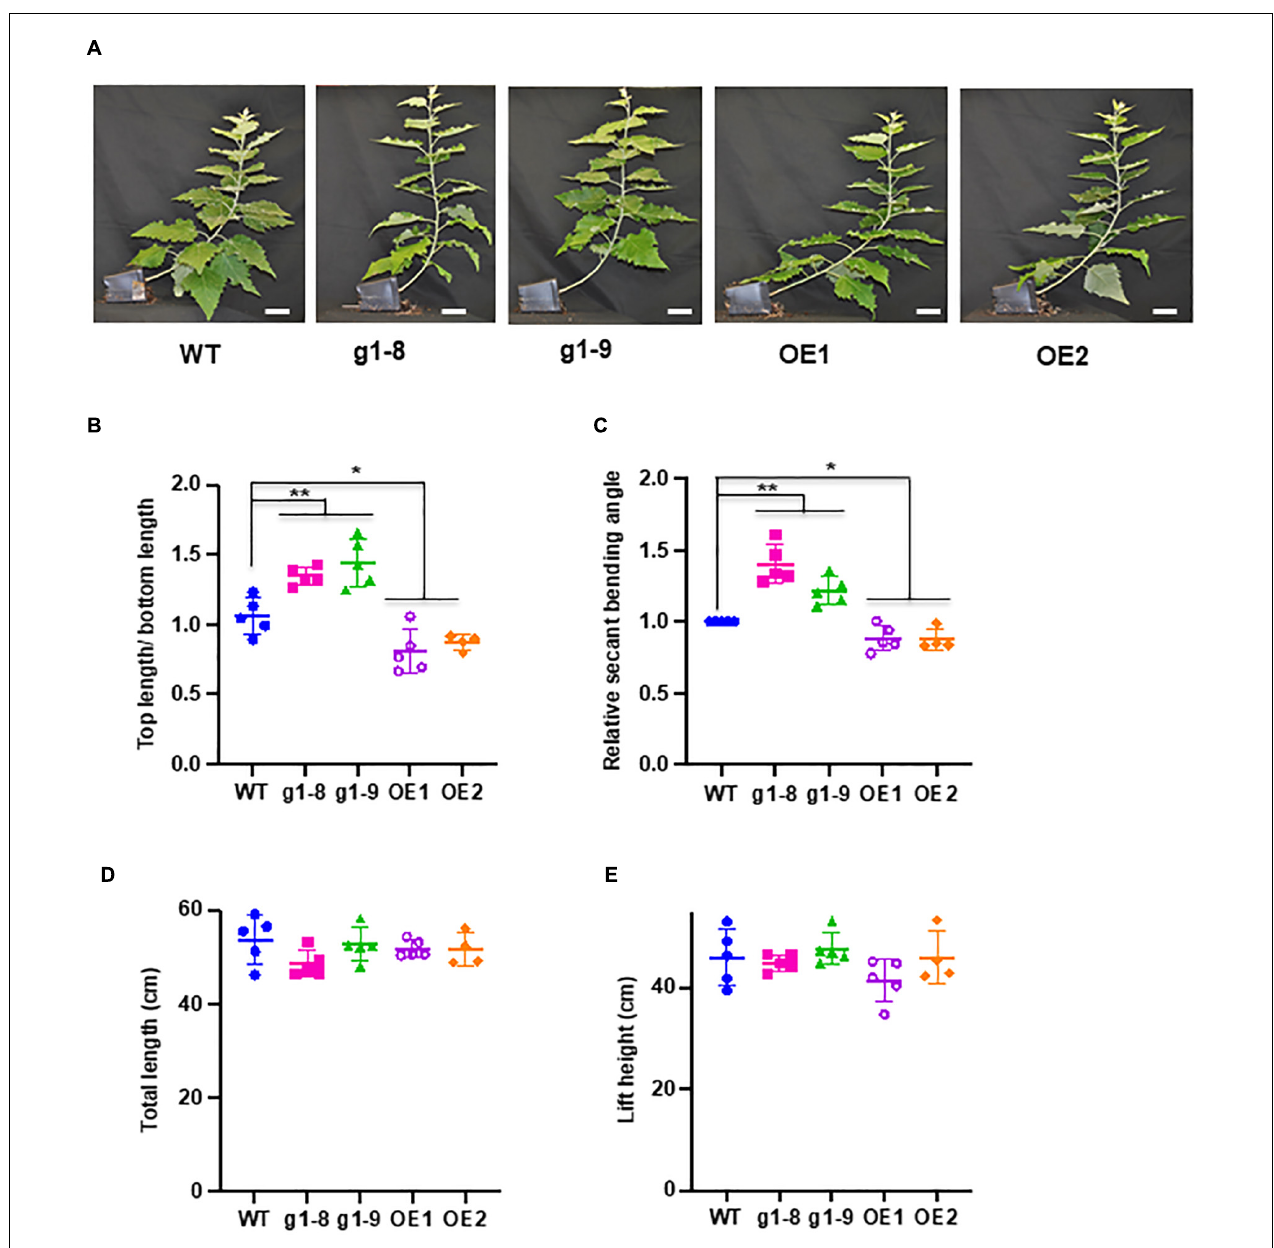
FIGURE 4 | Response of PHBMT1 knockout mutant and OE lines to gravitropic stimulation. (A) Morphology of hybrid aspen plantlets at the end point of 3-week gravitropic stimulation to the wild type (WT), phbmt1 knockout (g1-8, g1-9), and OE lines (OE1 and OE2). Bar = 5 cm. (B) The ratio of the top (near) vertical stem length/bottom inclined curving stem length of the WT, phbmt1 mutant (g1-8 and g1-9), and OE plantlets (OE1 and OE2) under gravitropic stimulation. (C) The calculated relative stem secant binding angle of the WT, phbmt1 (g1-8 and g1-9), and OE plantlets (OE1 and OE2) under gravistimulation. The stem secant binding angle of each corresponding WT was set as 1. (D,E) The total stem length (D) and the lift height (E) of the WT, phbmt1 knockout (g1-8 and g1-9), and OE plantlets (OE1 and OE2) at the end point of 3-week gravitropic stimulation. Data represent means ± SD of four or five biological repeats. Asterisk indicates significant difference compared with the corresponding WT, * P < 0.05, ** P < 0.01 (Student’s t